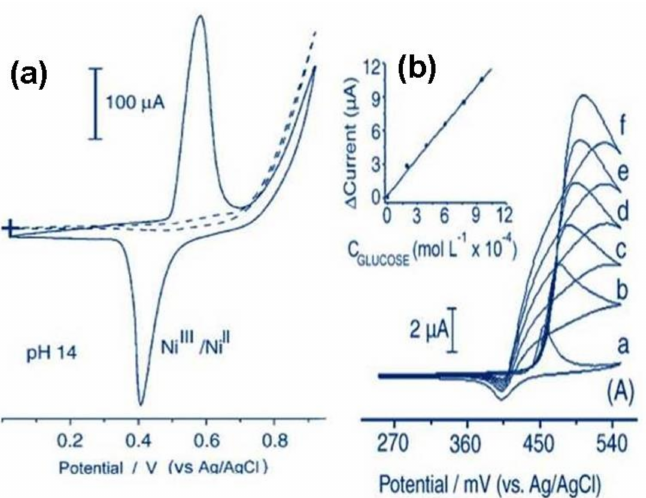
Figure 9. ( a ) The electrochemical behavior of Ni-TRP in 0.1 M NaOH (solid line) and 1.0 M DMSO. The formations of anodic and cathodic peaks in the alkaline media are assigned to the Ni(II) → Ni(III) and Ni(III) → Ni(II) transitions, respectively; ( b ) Response of the Ni-TRP electrode in presence of a diverse concentration of glucose (a = 0M, b = 2 × 10 − 4 M, f = 1 × 10 − 3 M). Redrawn from Reference